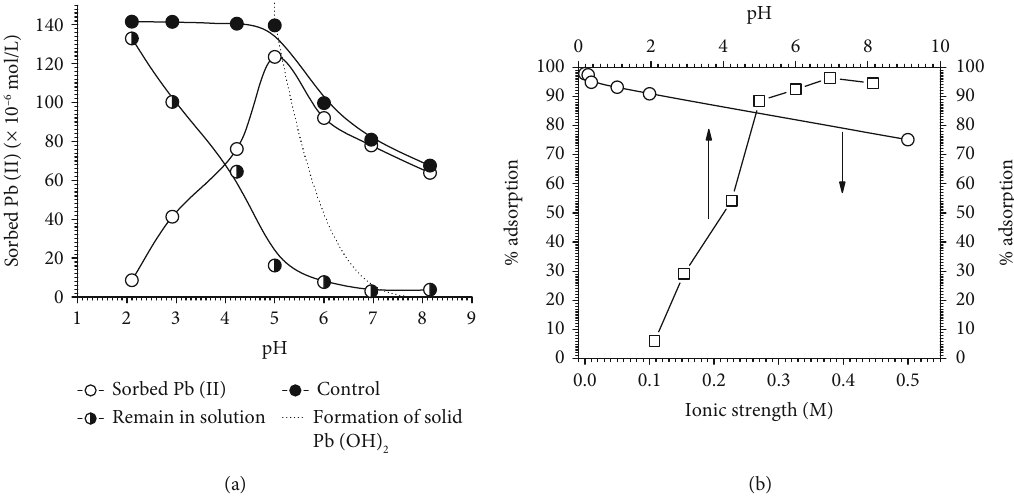
Figure 4: (a) Optimum pH of Pb(II) adsorption onto MHDHA; (b) % adsorption of Pb(II) onto MHDHA as a function of pH and ionic